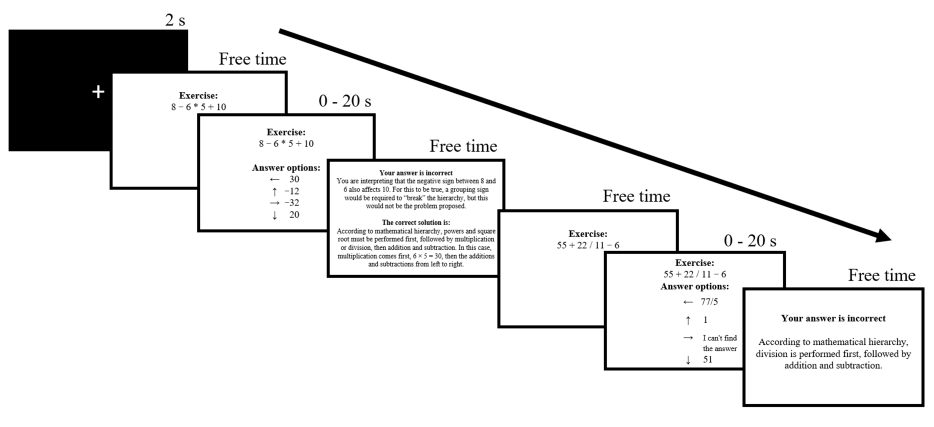
Figure 4. Task structure in the case of incorrect responses. Structure of the feedback presentation and a second approach following an incorrect response by the